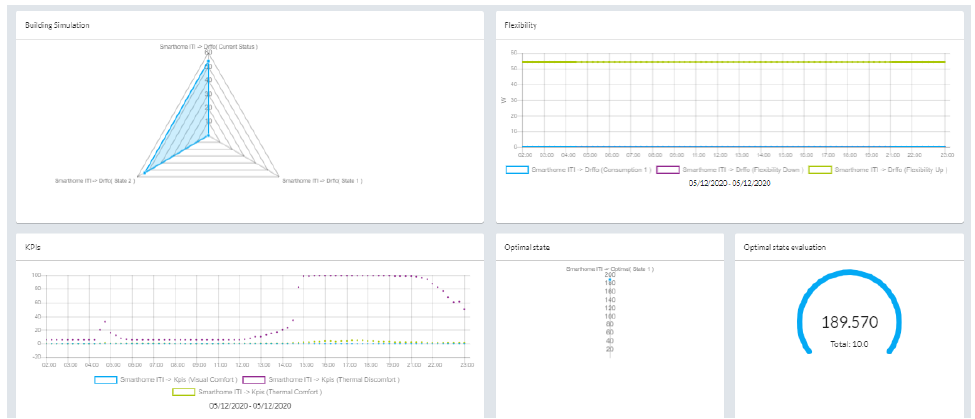
Figure 13. DRFFO tool monitoring and real-time visualization to the